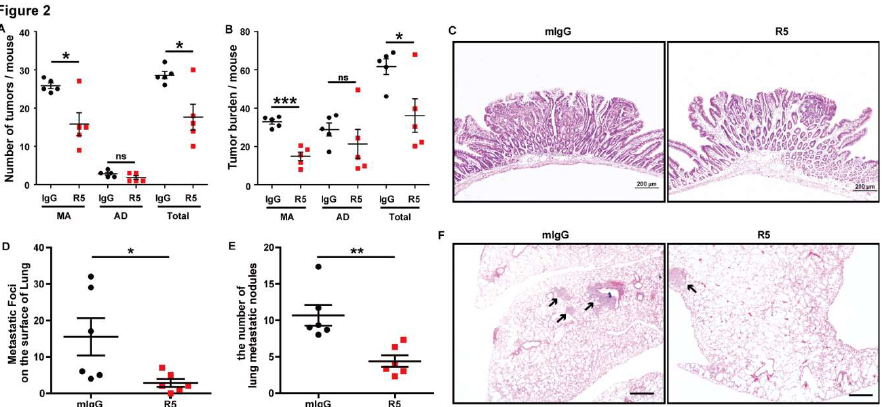
Figure 2. Specific blocking of Slit2/Robo1 signaling suppresses tumor growth and metastasis of CRC in vivo. The tumors were classified into microadenoma (MA, <2 mm) and adenoma (AD, ≥2 mm) only based on the tumor diameters. The number ( A ) and burden ( B , total tumor volume in the intestine per mouse) of tumors of microadenoma and total types of tumor (both microadenoma and adenoma) were significantly inhibited by specific blockage of Slit2/Robo1 signaling by R5 compared with the mIgG group. The number and burden of adenoma were also decreased in the intestine of R5-treated Apc Min/+ mice compared with that in mIgG-treated mice. However, there were no significant differences in the tumor number and tumor burden between the two groups due to the individual differences of mice. ( C ) R5 treatment decreased the pathological stage of tumors in Apc Min/+ mice compared with that of the mIgG-treated mice. Most of the intestinal tumors were adenoma in mIgG-treated Apc Min/+ mice, and most hyperplasia can be seen in the intestines of R5-treated Apc Min/+ mice. The lung metastasis tumor model of Lovo cells was constructed and treated with R5, a monoclonal antibody that specifically recognizes human, rat, and mouse Robo1, and mIgG. ( C ) The number of lung metastatic foci on the face of lung tissues was significantly decreased in the R5-treated group compared with the mIgG-treated group. ( D ) The lung tissues were cut into sections and stained with hematoxylin and eosin. The number of lung metastatic foci in lung tissue sections was counted. R5 could markedly decrease the number of metastatic foci in lung tissue sections compared with mIgG-treated mice. ( E ) Representative of metastatic foci in lung tissues sections in R5 and mIgG-treated mice. There were fewer lung metastatic foci in the slices of the R5-treated mice than in the mIgG-treated mice. n = 6. *: p < 0.05, **: p < 0.01, and ***: p < 0.001. Scale bars: 500 μm.